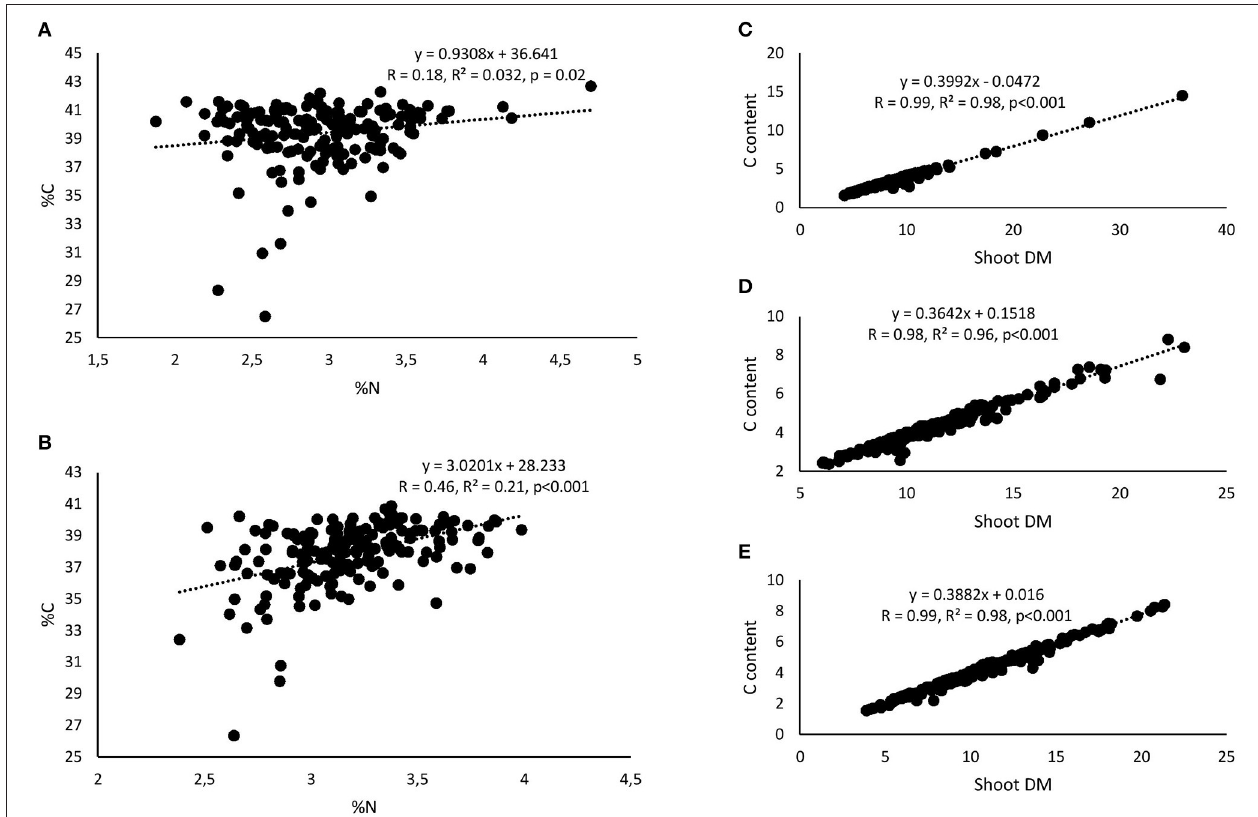
FIGURE 7 | Correlation and regression analysis between shoot %N and %C of 15 cowpea genotypes planted in (A) Nyankpala and (B) Savelugu and between shoot dry matter (DM) and C content at (C) Nyankpala, (D) Savelugu, and (E)